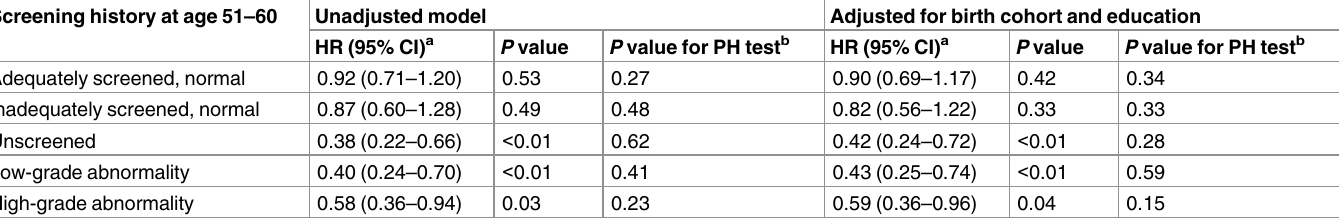
Table 3. Cause-specific hazard ratio of cervicalcancerfrom age 61 to age 80 comparing women screenedand unscreenedat age 61–65,by screen- ing history at age 51–60, based on Cox regression